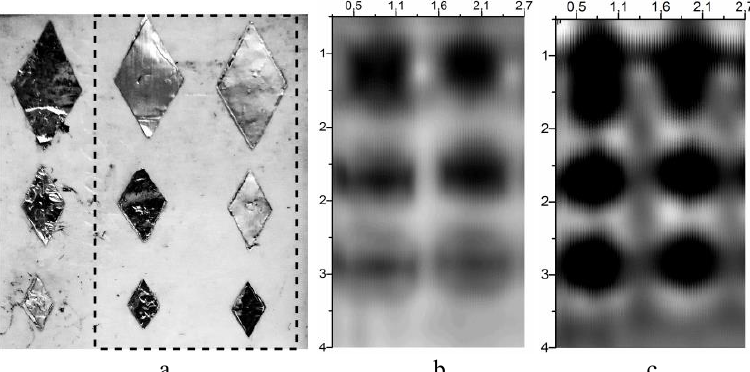
Fig. 3. Appearance of the test sample (a); image of a scanned sample without (b) and with a focusing element (c) at a frequency of 42 GHz. Black color corresponds to the minimum signal detector, white to the